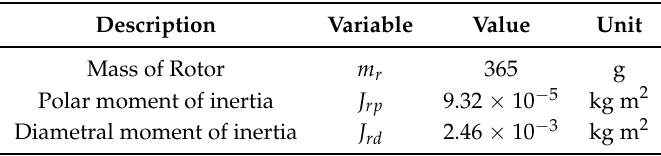
Table 5. Parameters of the varified rotor.